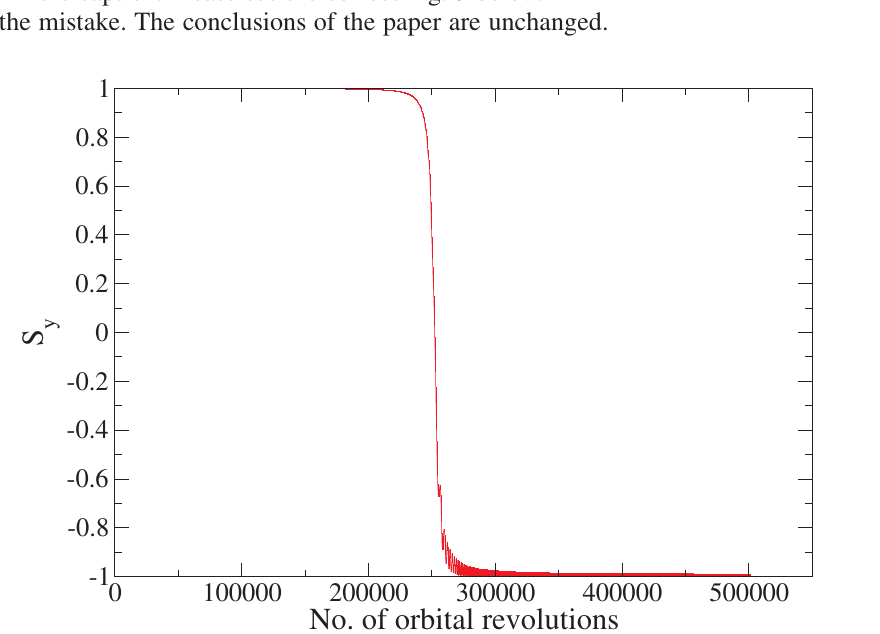
~ (cid:1) osc was increased to 2.28 mrad with a phase difference of